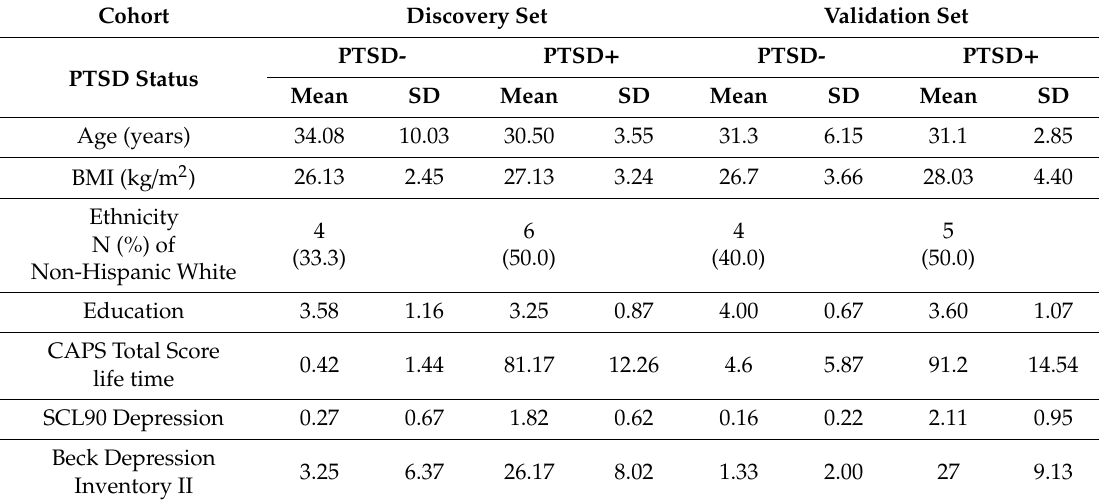
Table 1. Demographic and clinical